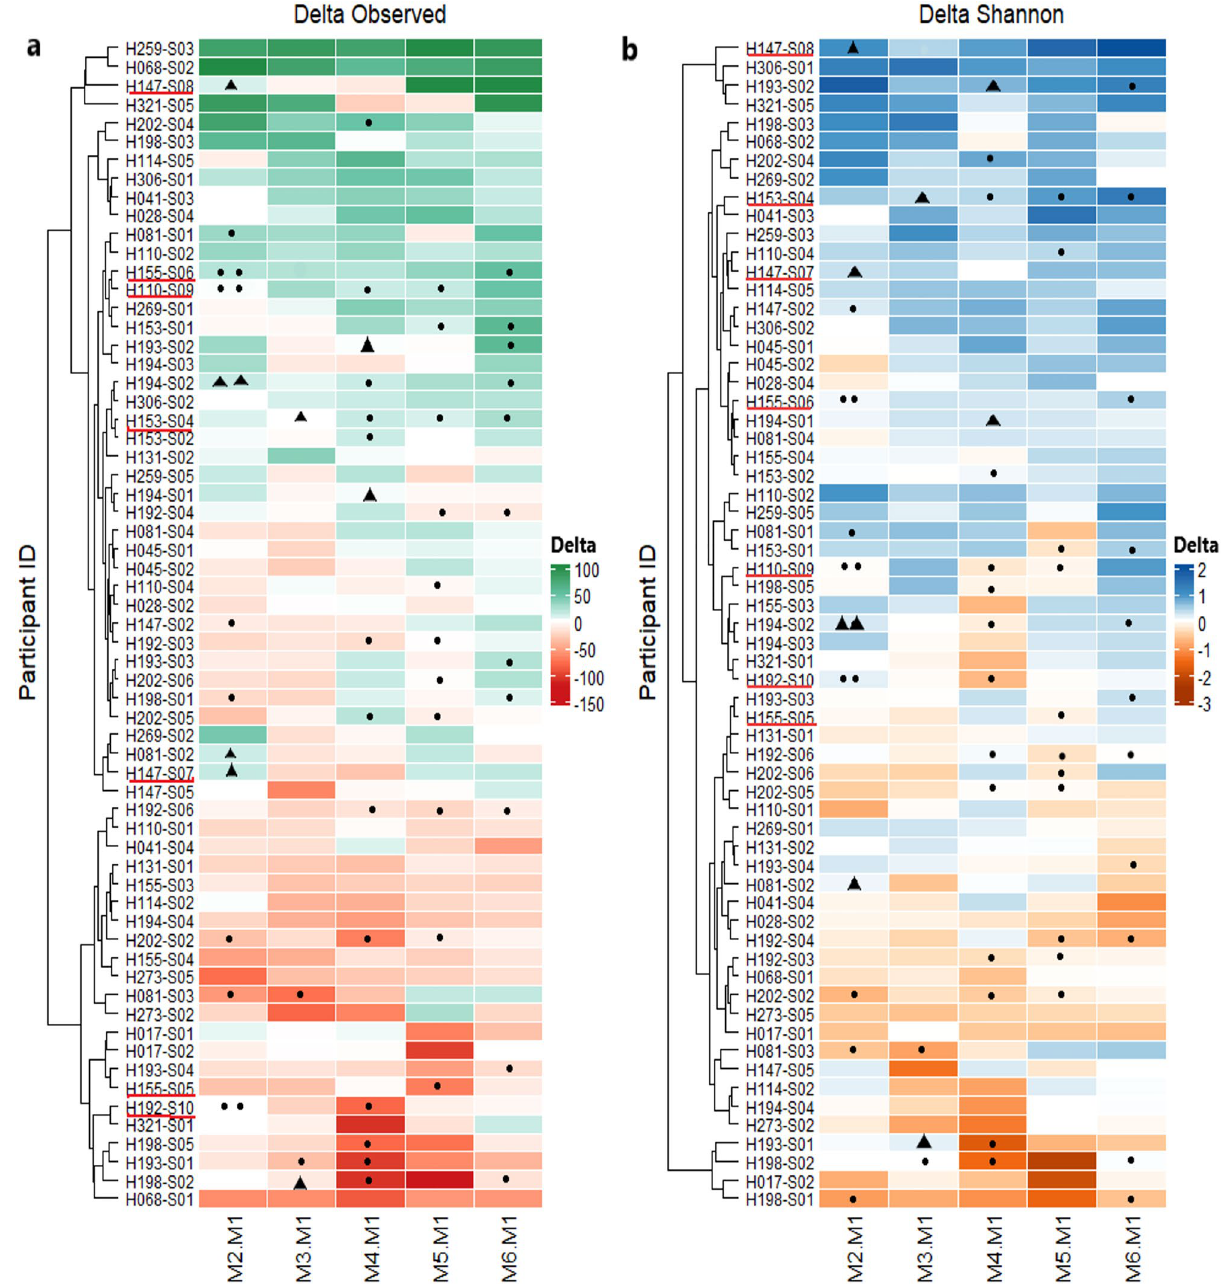
Figure 3. Within-subject shifts in microbial richness and diversity throughout the 6-months follow-up. The heatmaps depict the changes in microbial richness ( a ) and Shannon diversity ( b ) within each study subject between the first month (baseline) and the following months during the study period. Circles and triangles indicate that subjects used antibiotics within four weeks of the later time point (circles for cephalosprorins and triangles for penicillin/amoxicillin). The red lines under the participant ID indicate individuals under 6 years of age. The colour legends (Delta) indicate the difference of alpha diversity from diversity at baseline with Shannon median 3.69 (IQR 3.31–4.11) when compared to the Dutch individuals with median 3.95 (IQR 3.72–4.13), ( p = 0.028). This supports the hypothesis of a reduction in microbial diversity as a pants in the Ha Nam cohort was associated with the similarity of their microbiota to that of Dutch individuals. Ordination analyses showed that participants with a more resistant microbiota did neither cluster apart from individuals with a less resistant microbiota nor was the microbiota of these participants more (dis)similar to that of Dutch individuals (Figs. 5, S3 and S4).